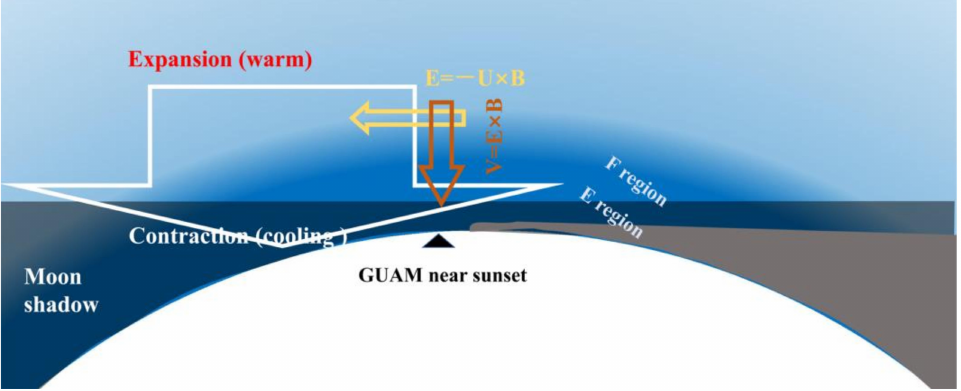
Figure 8. Illustration of the possible mechanism that contributes to the related ionospheric changes as the moon shadow meets the sunset terminator. The white arrow indicates the convergence that contains the downward press over Guam and westward wind disturbance over the western